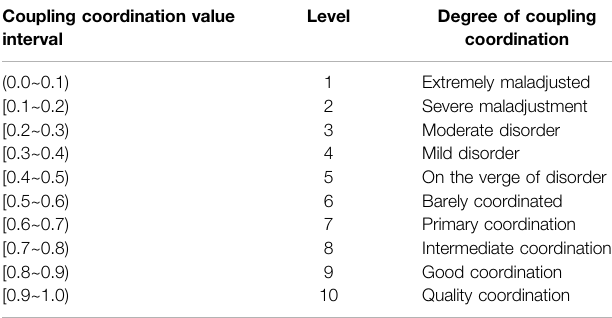
TABLE 2 | Coupling coordination value and grade